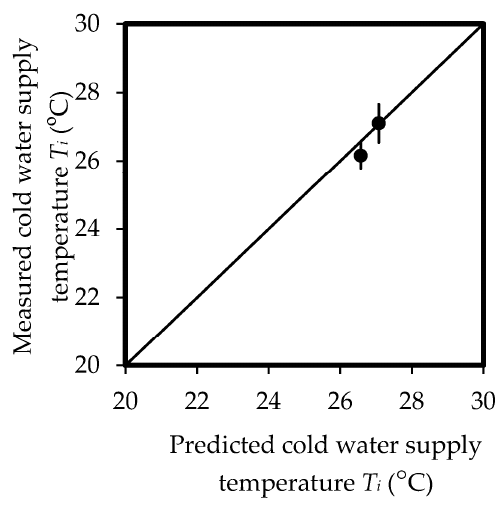
Figure 3. Cold water supply temperatures at showerheads.